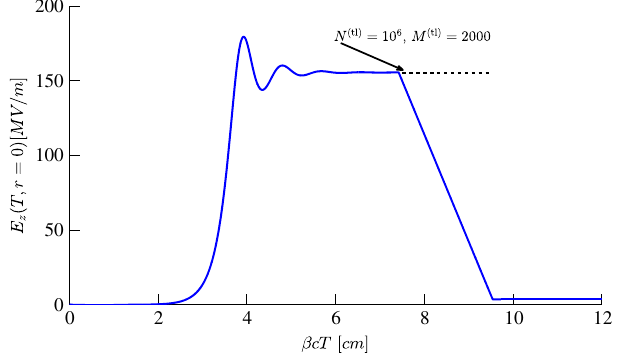
FIG. 10. Wake dynamics (solid curve) for resonance mode number of s 0 ¼ 18 . The second trailing train bunch (dashed curve) is located at the saturation regime.